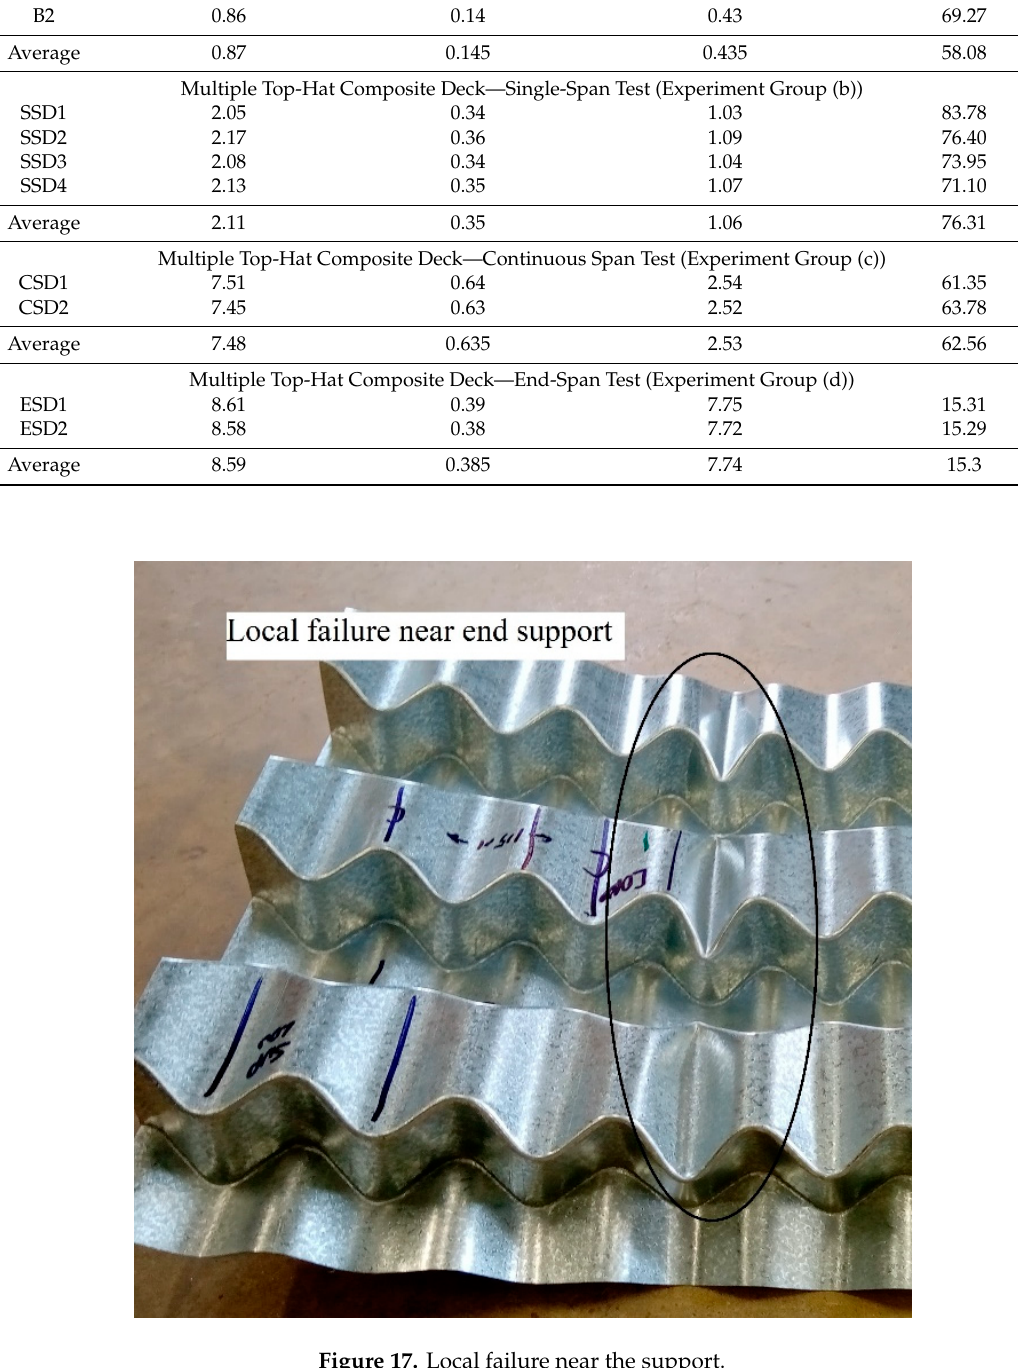
Figure 18. Load vs. displacement for end support deck tests. 5. Comparison of Deck Strength with Design Strengths Predicted by the Australian Code 5.1. Assessment of Hat Sections (Experiment Group (a)) and Single-Span Multiple Hat Sections (Experiment Group (b)) Ultimate resistances for the considered decks were calculated according to AS 4600:2018 [32] and AS 4100:1998 [31]. This is to assess the relevance of the formulas available in the codes for the new deck types considered in the current research. Moment resistances calculated for top-hat sections are